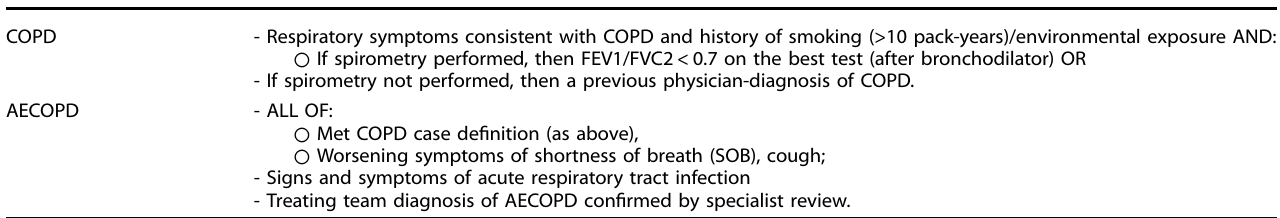
Table 3. Study case de fi nitions. COPD - Respiratory symptoms consistent with COPD and history of smoking (>10 pack-years)/environmental exposure AND: ○ If spirometry performed, then FEV1/FVC2< 0.7 on the best test (after bronchodilator) OR - If spirometry not performed, then a previous physician-diagnosis of COPD. AECOPD - ALL OF: ○ Met COPD case de fi nition (as above), ○ Worsening symptoms of shortness of breath (SOB), cough; - Signs and symptoms of acute respiratory tract infection - Treating team diagnosis of AECOPD con fi rmed by specialist